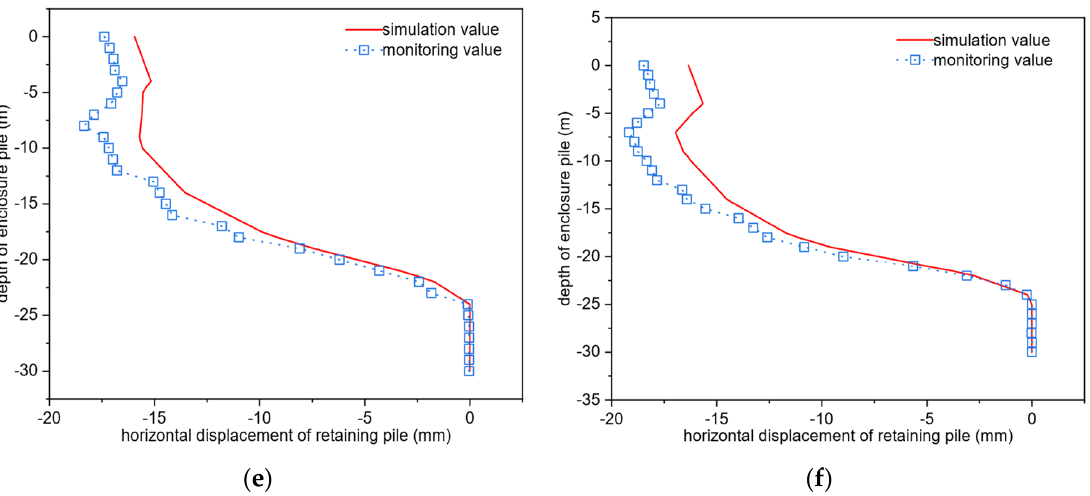
Figure 12. Comparison of horizontal deformation of retaining piles in different steps. ( a ) step 1; ( b ) step 2; ( c ) step 3; ( d ) step 4; ( e ) step 5; ( f ) step 6.